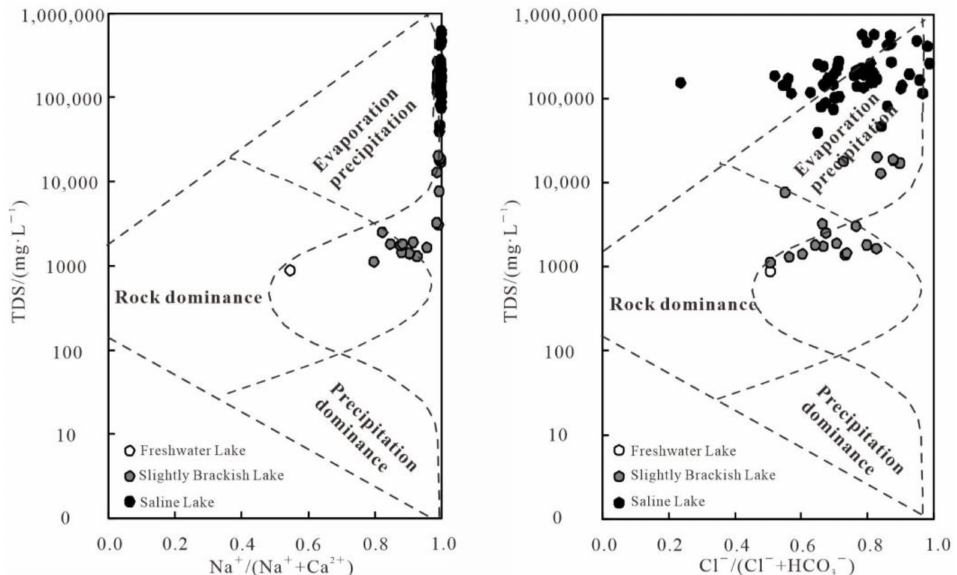
Figure 4. Gibbs diagram of the water samples in the Badain Jaran